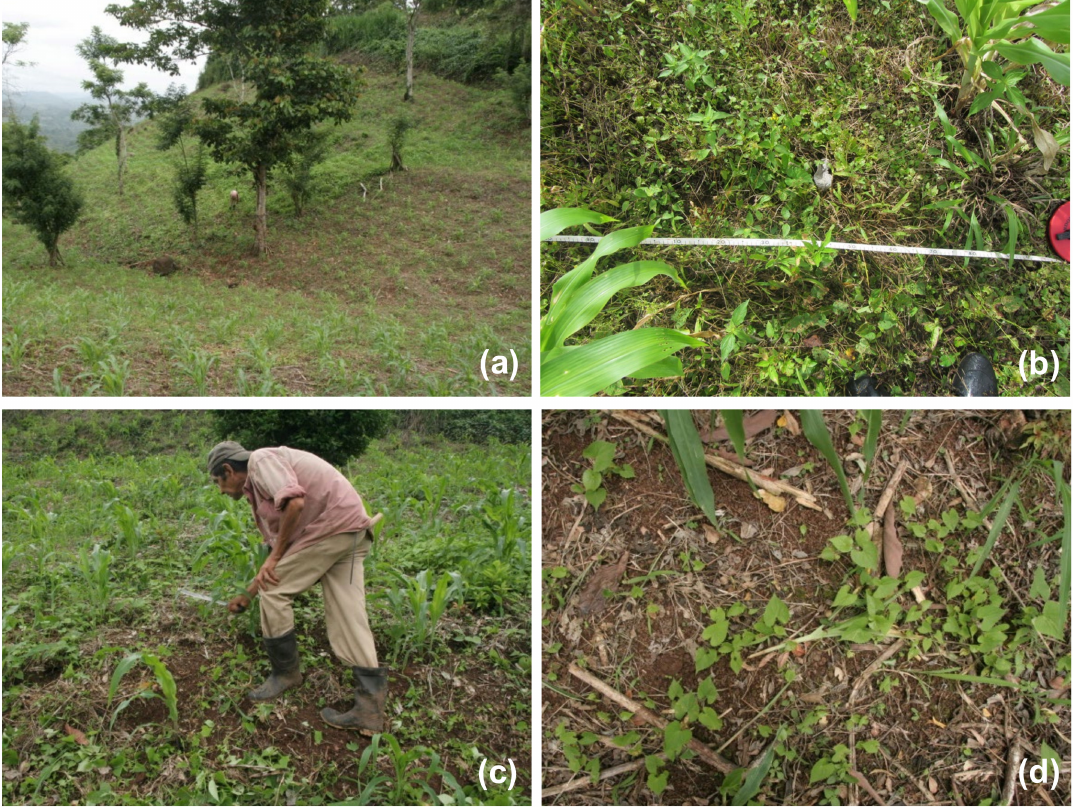
Figure 4. Visual indicators of the reduced stability of the litter layer after weed control: view of the whole plot ( a ); detail of the ground before weed control ( b ); weed control with machete ( c ); detail of the aspect after weed removal, with vegetal residues loose on the surface ( d ).